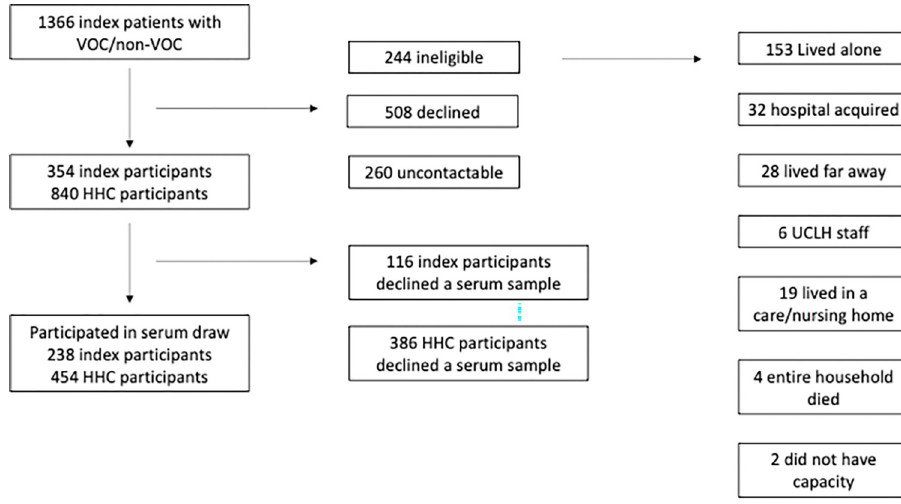
Fig 1. Flow diagram for recruitment into the